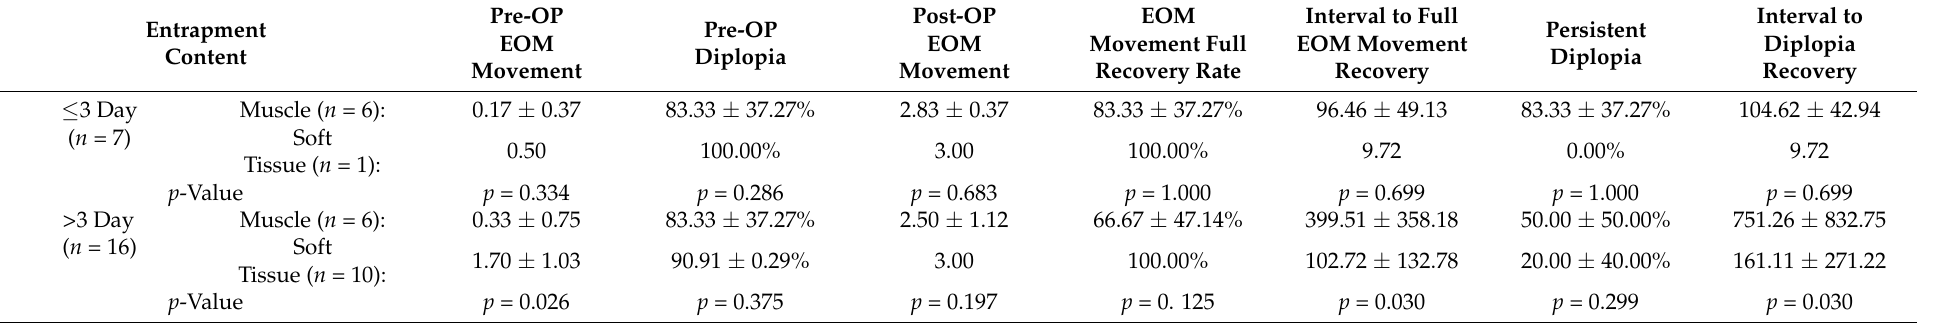
Table 4. Comparison of functional outcome by surgical time interval and subgroups of entrapment contents.